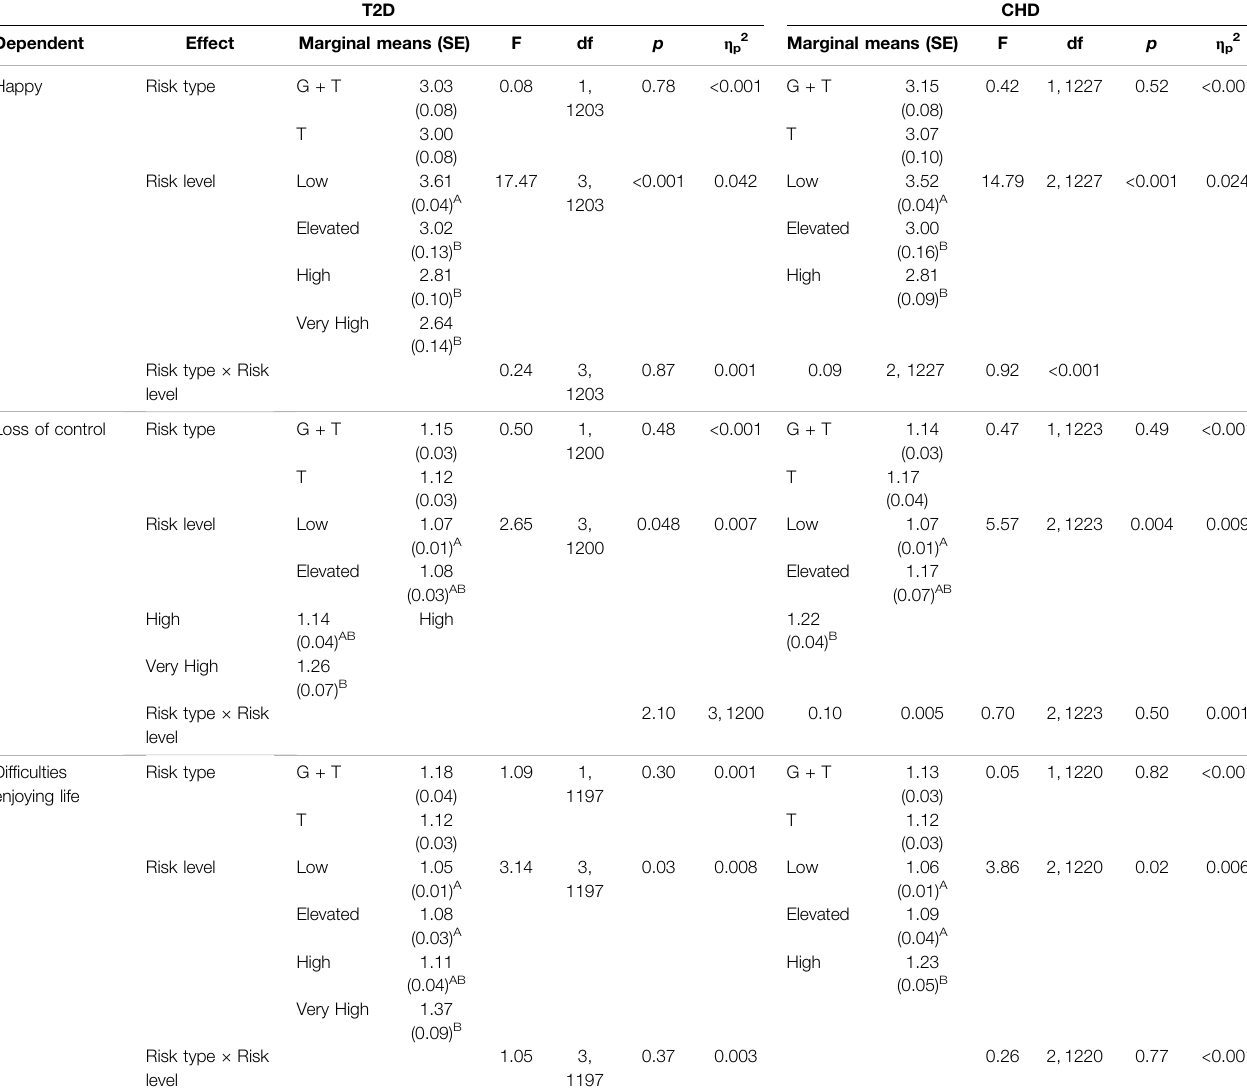
TABLE 3 | ( Continued ) Analysis of variance main effects and interactions: Emotional reaction to the test results concerning T2D and CHD